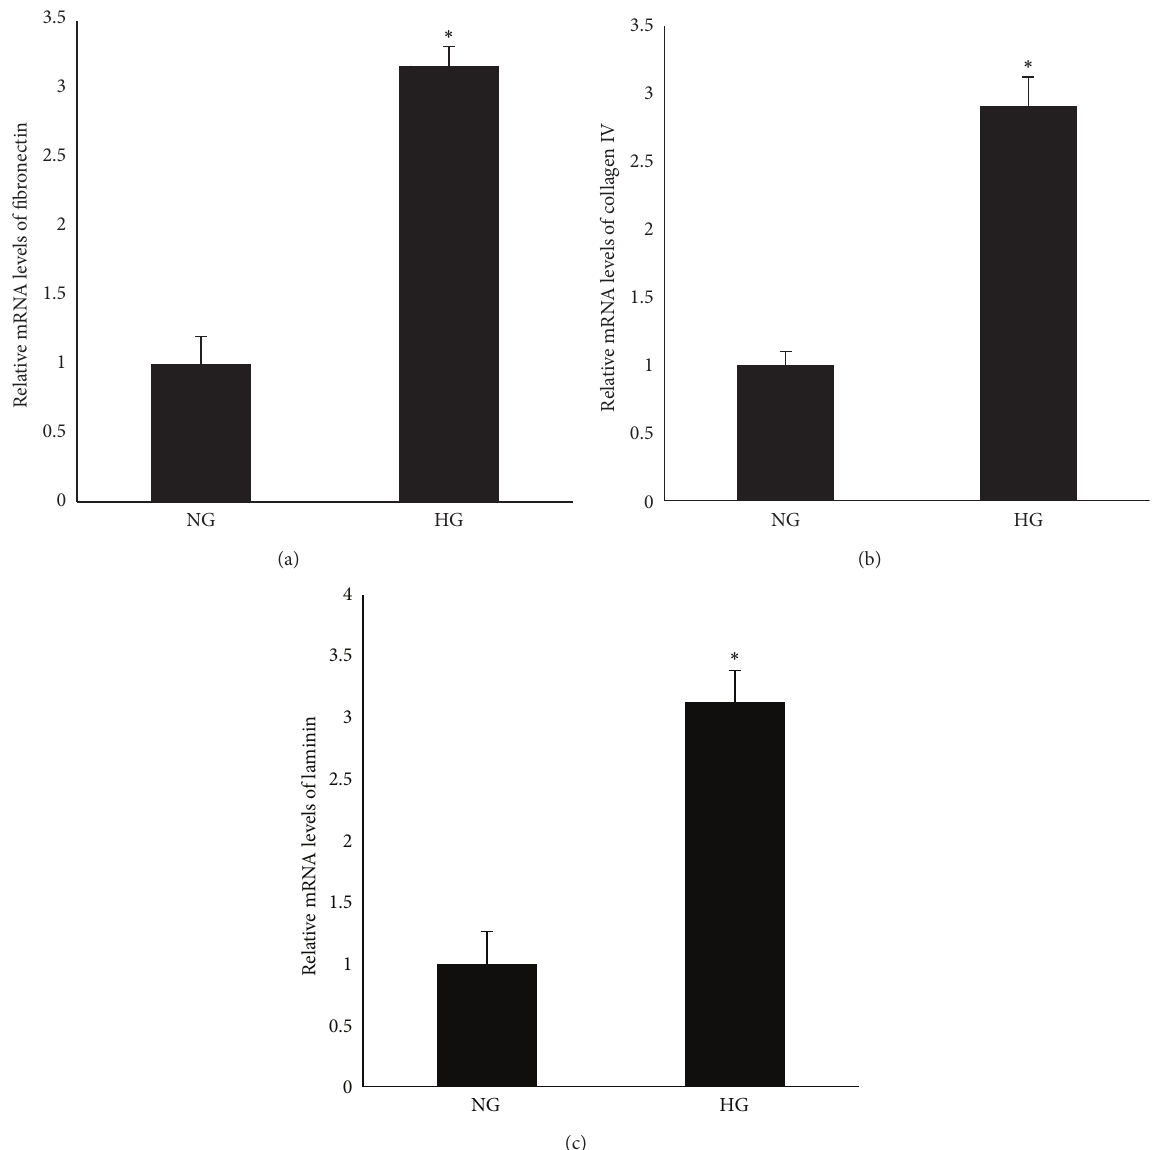
Figure 1: High glucose induced the mRNA expression of fibronectin, collagen IV, and laminin in RPE cells. RPE cells were exposed to NG (5.6 mM) or HG (25 mM) for 24 h before measuring the mRNA expression of fibronectin, collagen IV, and laminin. (a, b, c) Compared with NG, a real-time PCR analysis showed that the mRNA expression of fibronectin, collagen IV, and laminin was upregulated in response to HG. The data shown represent the mean ± SD of three independent experiments. ∗ 𝑃 < 0.01 versus